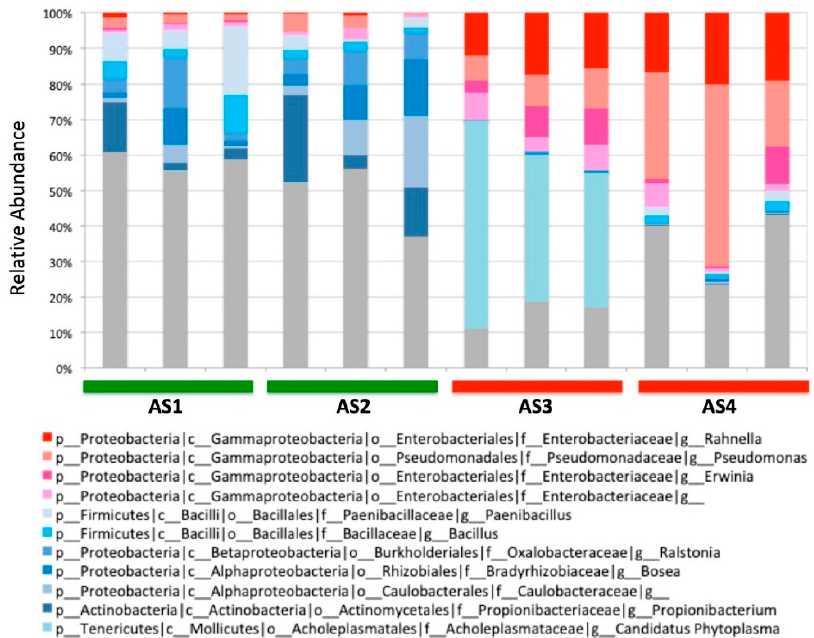
Figure 2. Microbial communities of four A. sinensis samples at the genus level. The most abundant genera are shown. The genera in the class Gammaproteobacteria are colored in reddish hues. Other abundant genera are shown in bluish colors. Three independent replicates were made for each